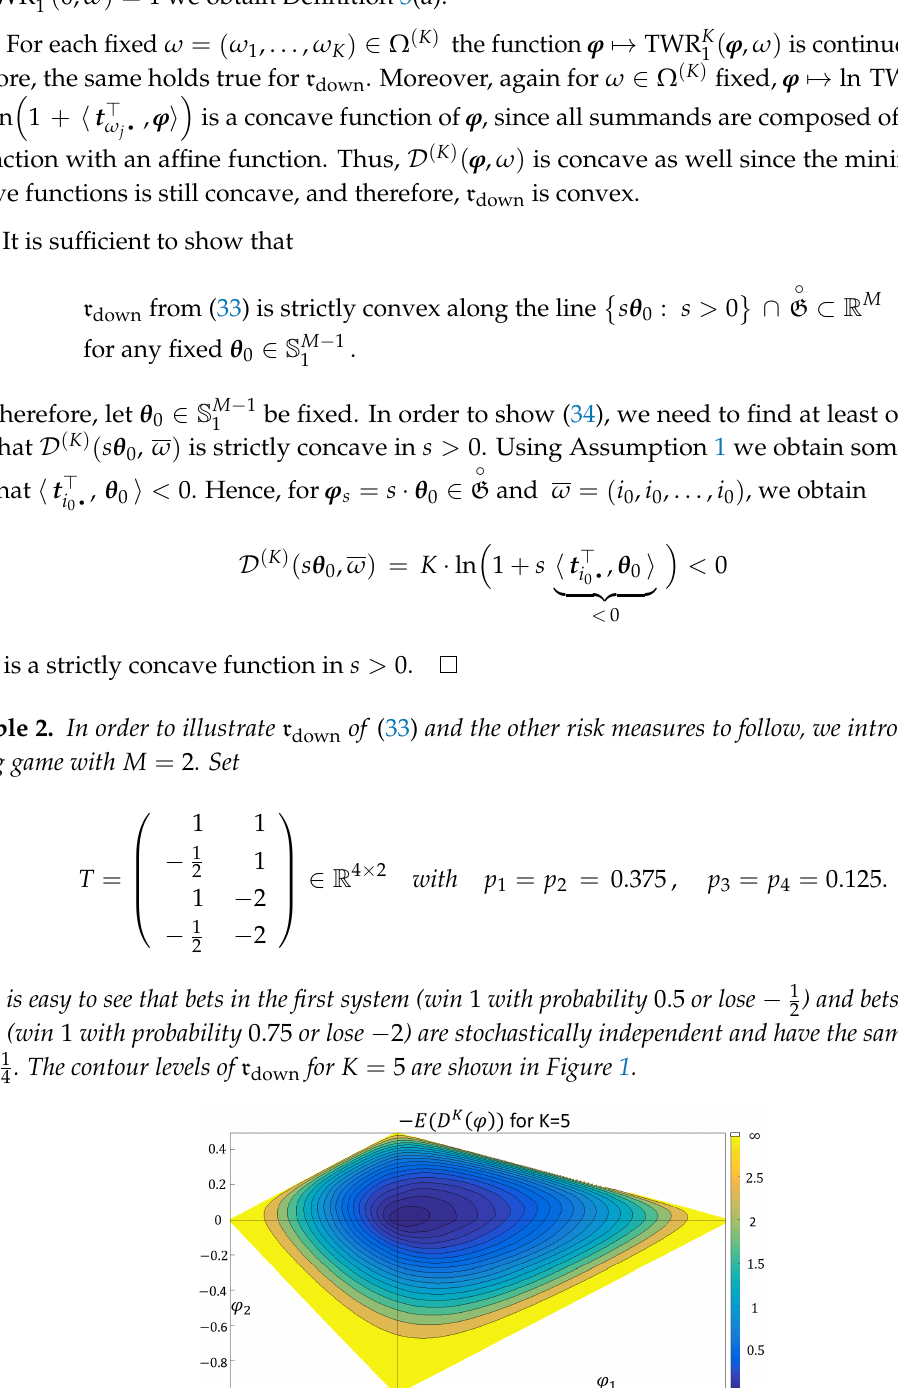
from (33) with K = 5 for T from Example down